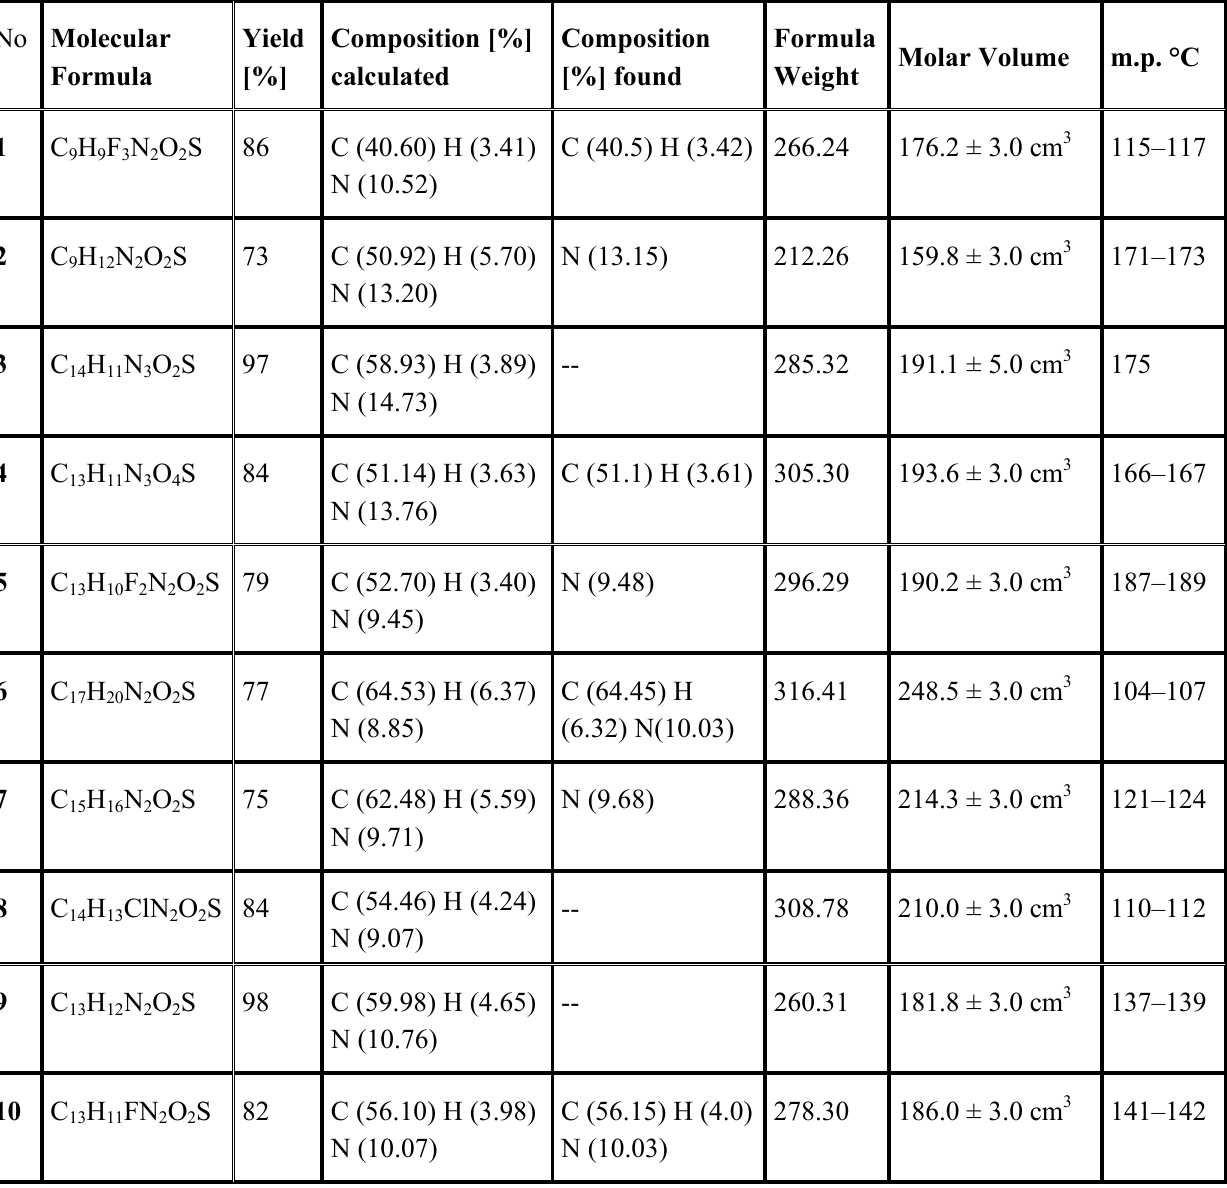
Table 1. Analytical data of